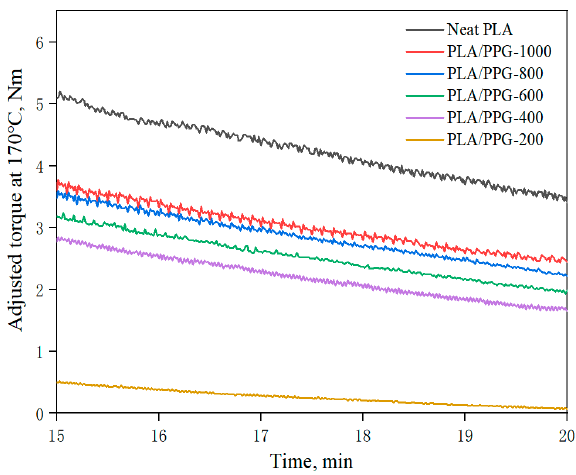
Figure 4. Temperature-adjusted torque versus time in the interval from 15 to 20 minutes of the neat PLA and PLA / PPG composites.